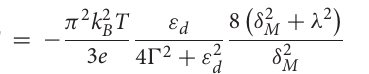
0, and for different δ M in (C) , (D) with λ =